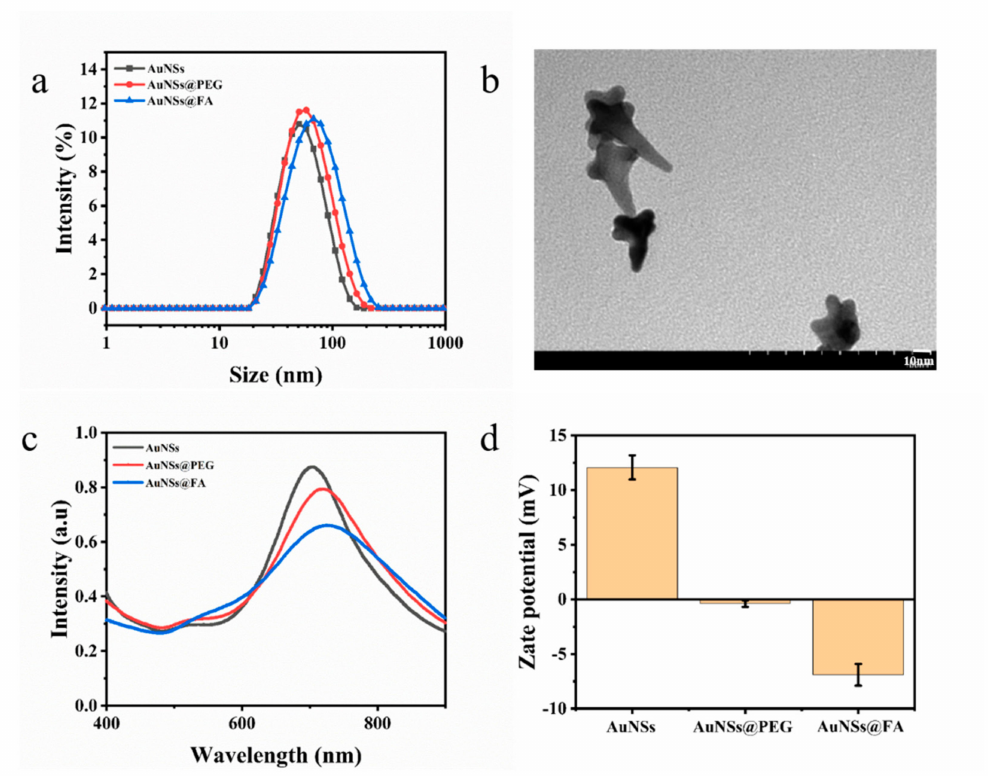
Figure 1. ( a ) The hydrated particle sizes of AuNSs, AuNSs@PEG, and AuNSs@FA. ( b ) Transmission electron microscopy images of AuNSs. ( c ) UV-Vis absorption spectra of AuNSs, AuNSs@PEG, and AuNSs@FA. ( d ) Zeta potentials of AuNSs, AuNSs@PEG, and AuNSs@FA. Results are presented as means ±